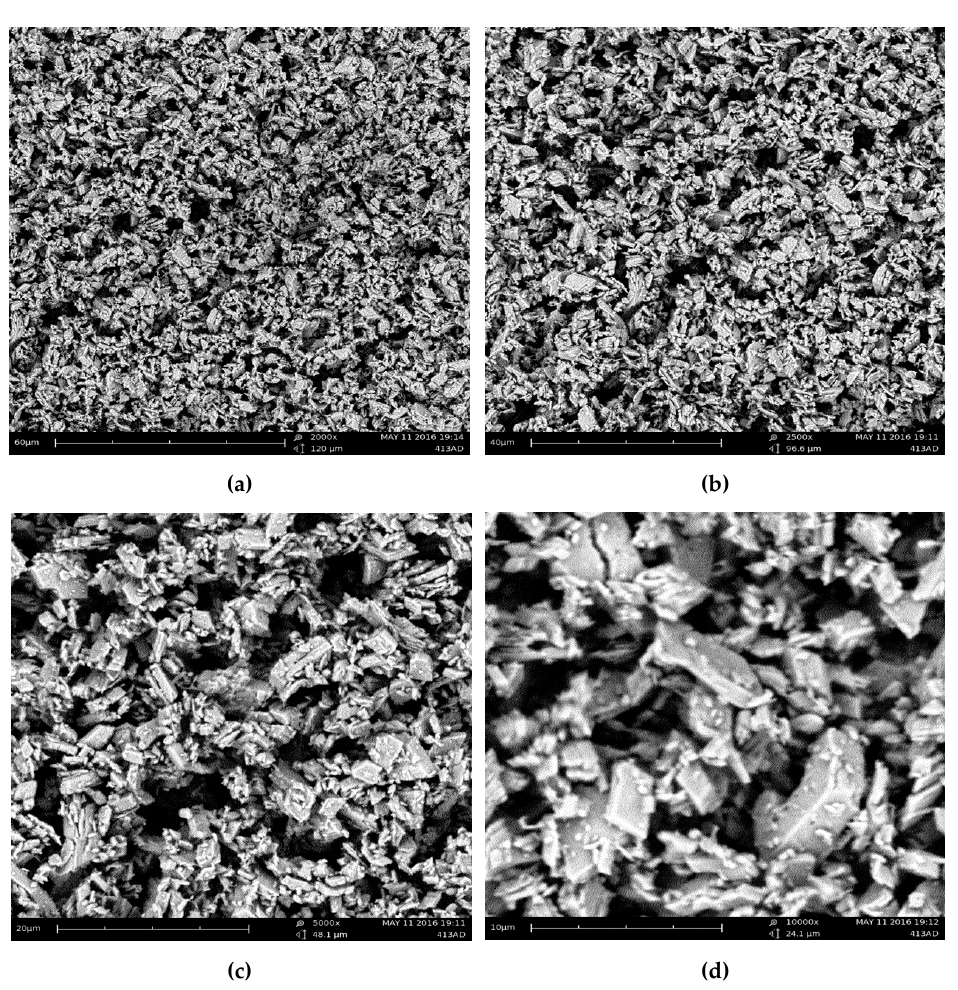
Figure 4. SEM images of the formed β -CD—oregano EO ICs at ( a ) × 2000, ( b ) × 2500, ( c ) × 5000 and ( d ) × 10000 magnification. ( d ) × 10000